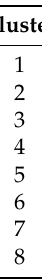
Table 6. Instances along the